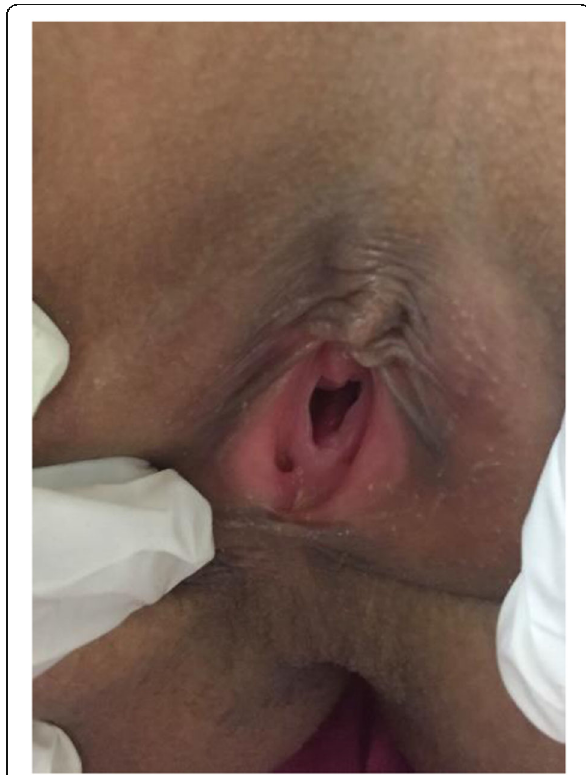
Fig. 1 Perineal canal: anolabial fistula without inflammation